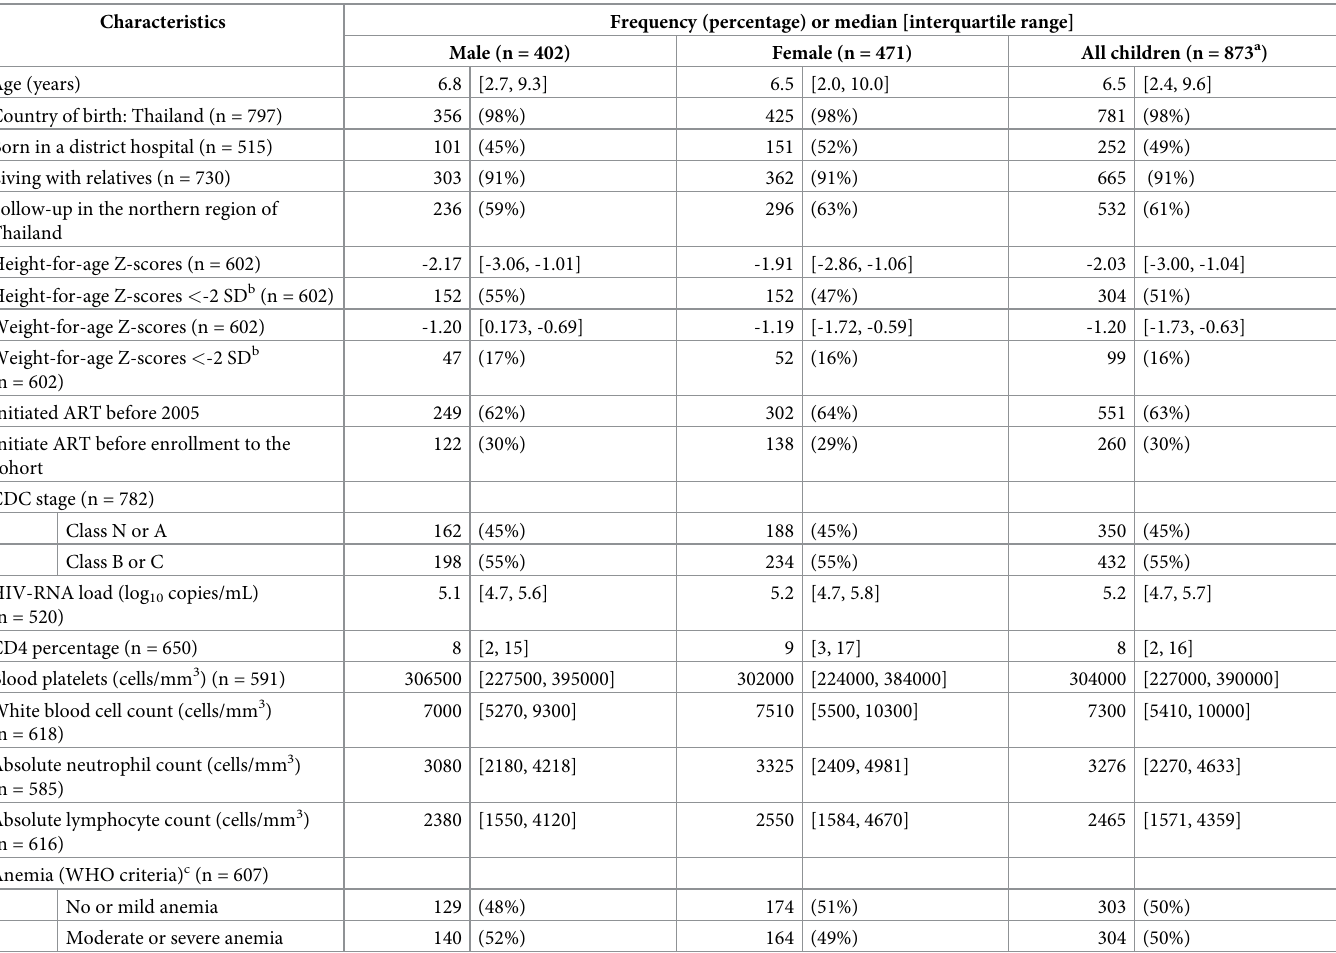
Table 1. Children’s characteristics at antiretroviral therapy